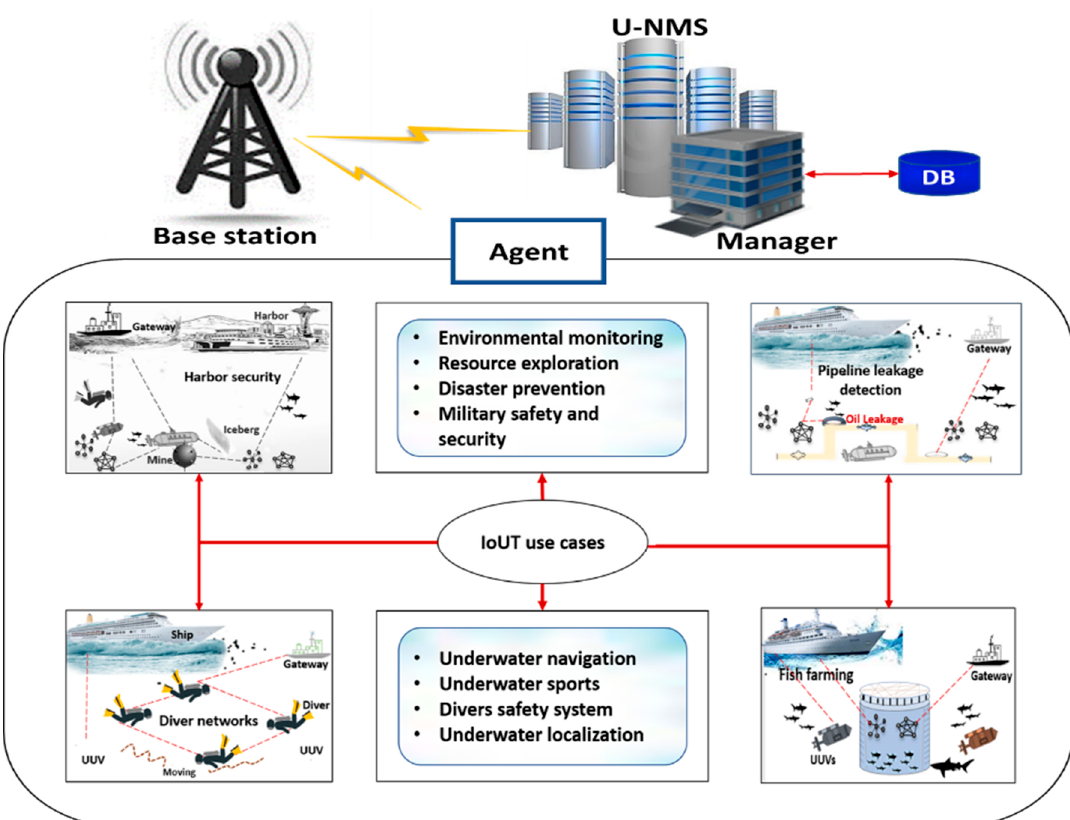
Figure 2. Internet of Underwater Things (IoUT) use cases.